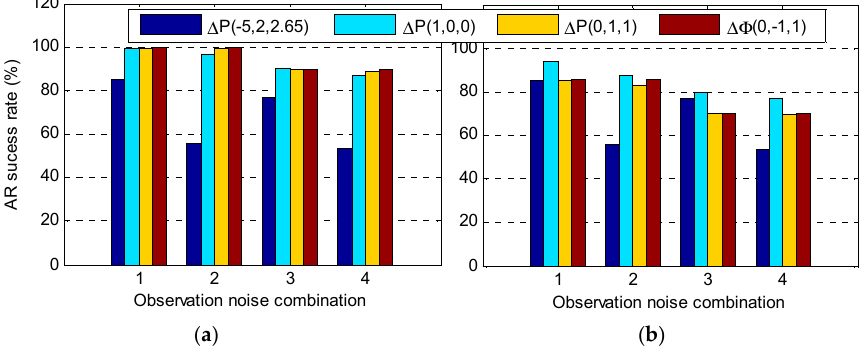
Figure 1. Ambiguity resolution (AR) success rate using four observations with different noise levels and double-di ff erence (DD) ionospheric delays: ( a ) DD ionospheric delay ∆ I = 40cm and ( b ) DD ionospheric delay ∆ I = 100cm.